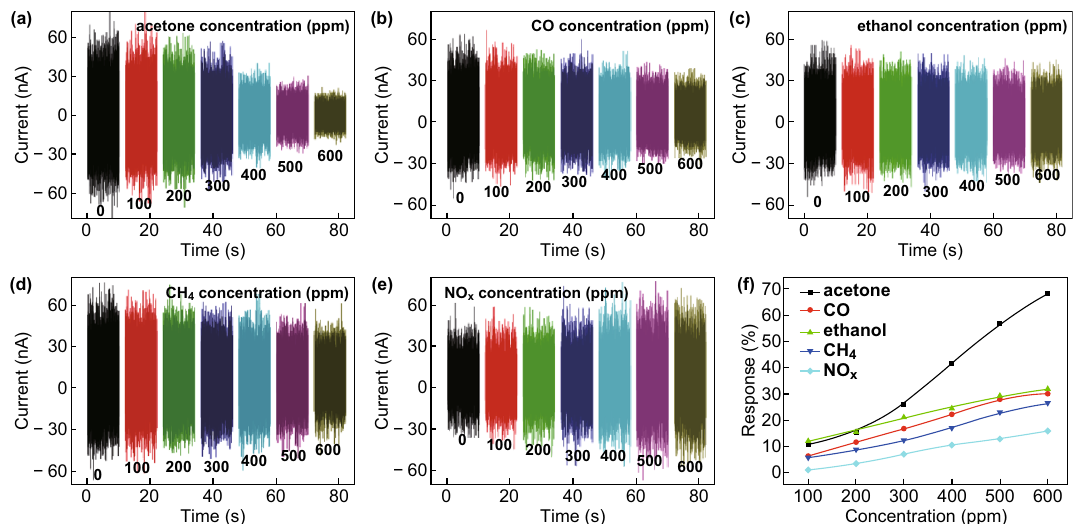
Fig. 3 Performances of PANI(SS) sensing unit. a – e The output current of PANI(SS) in response to acetone, CO, ethanol, CH 4 , and NO x with concentrations ranging from 0 to 600 ppm. f The relationship between the response and gas